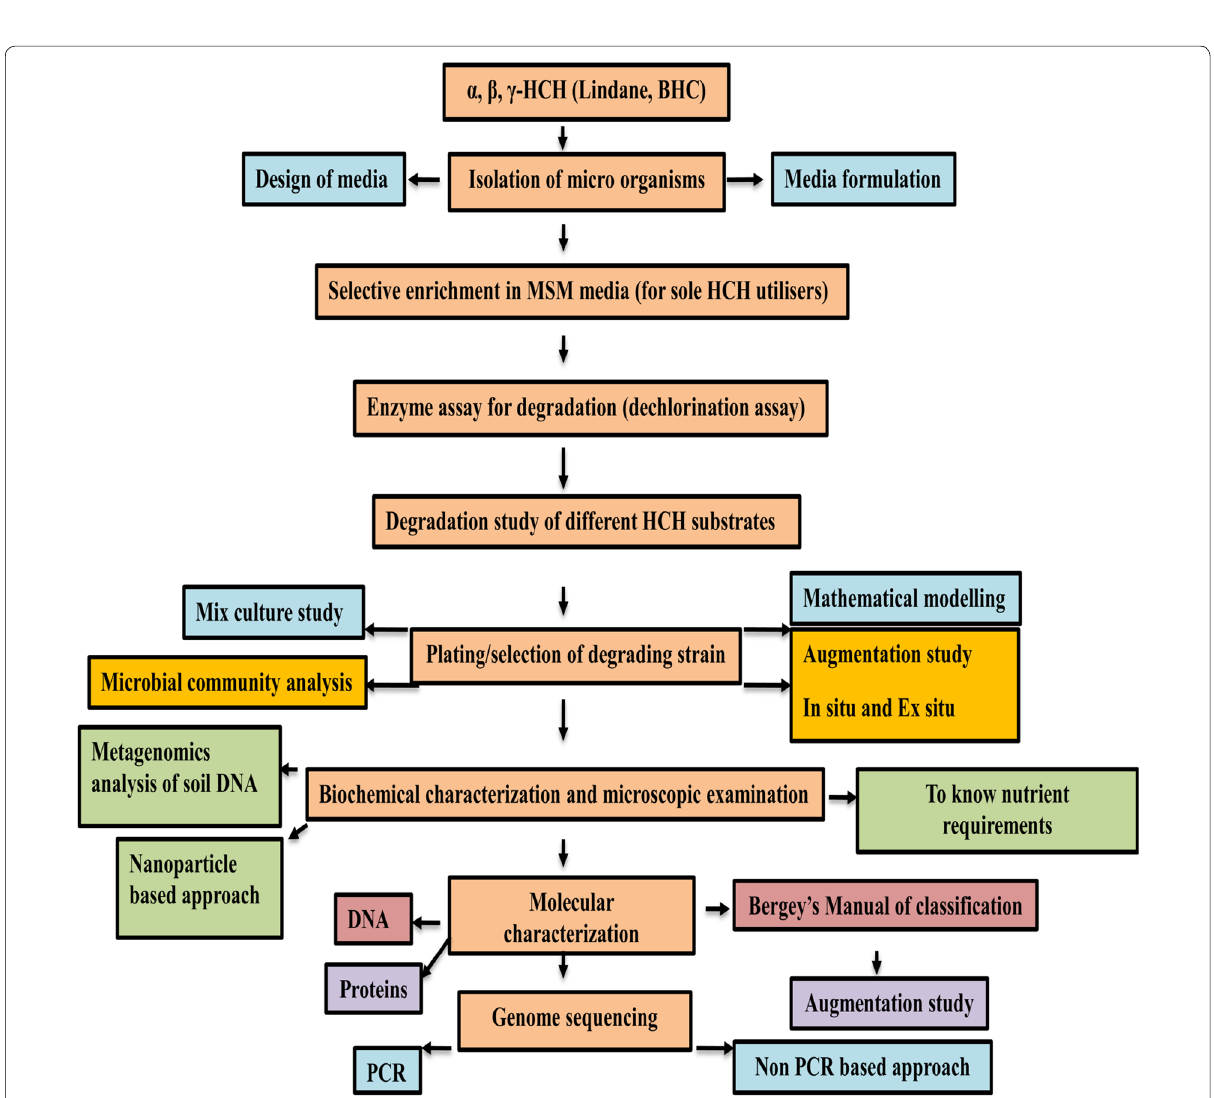
Fig. 2 Strategy employed for isolation, characterization and molecular study of potential HCH degrader from the environmental